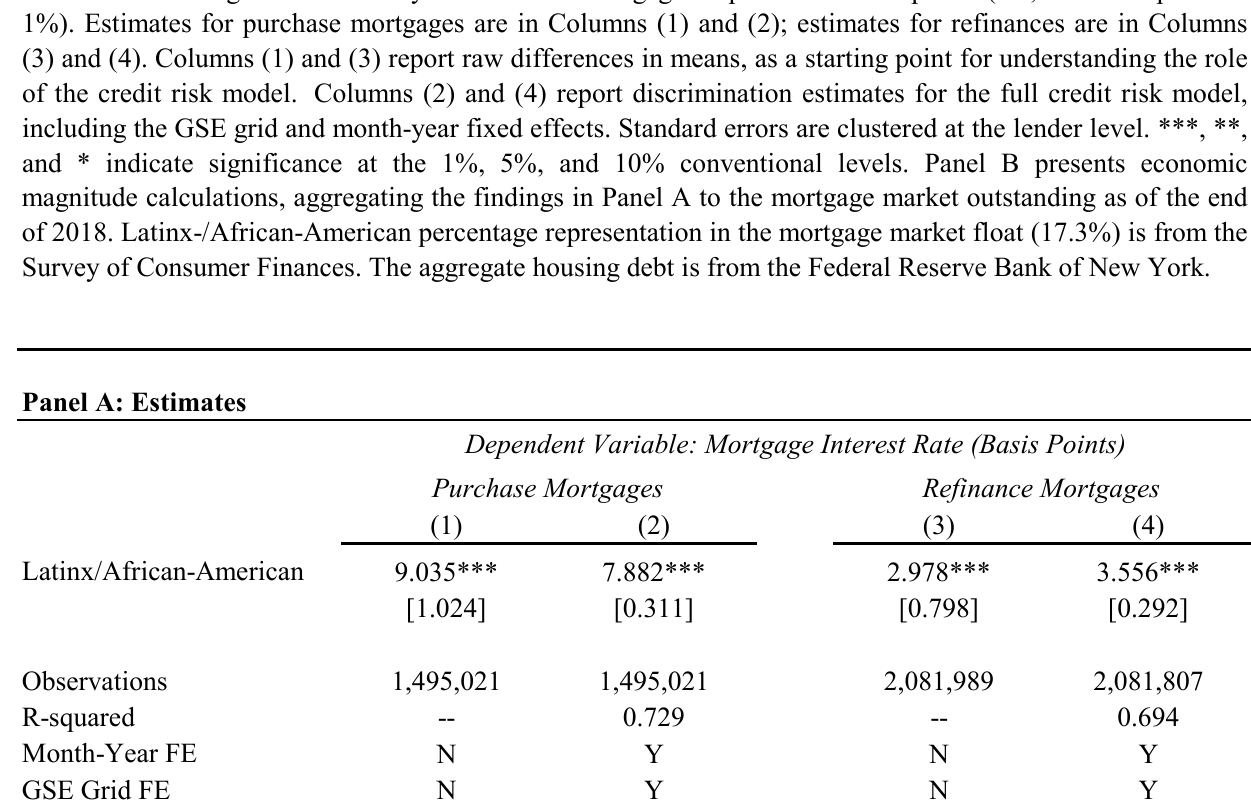
Table 2: Interest Rate